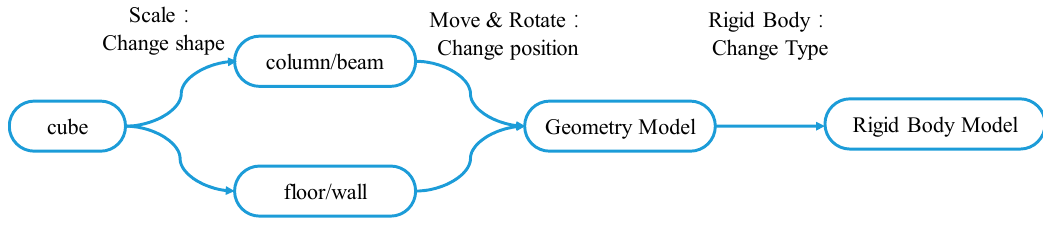
Figure 2. Solid model establishment method in Blender.